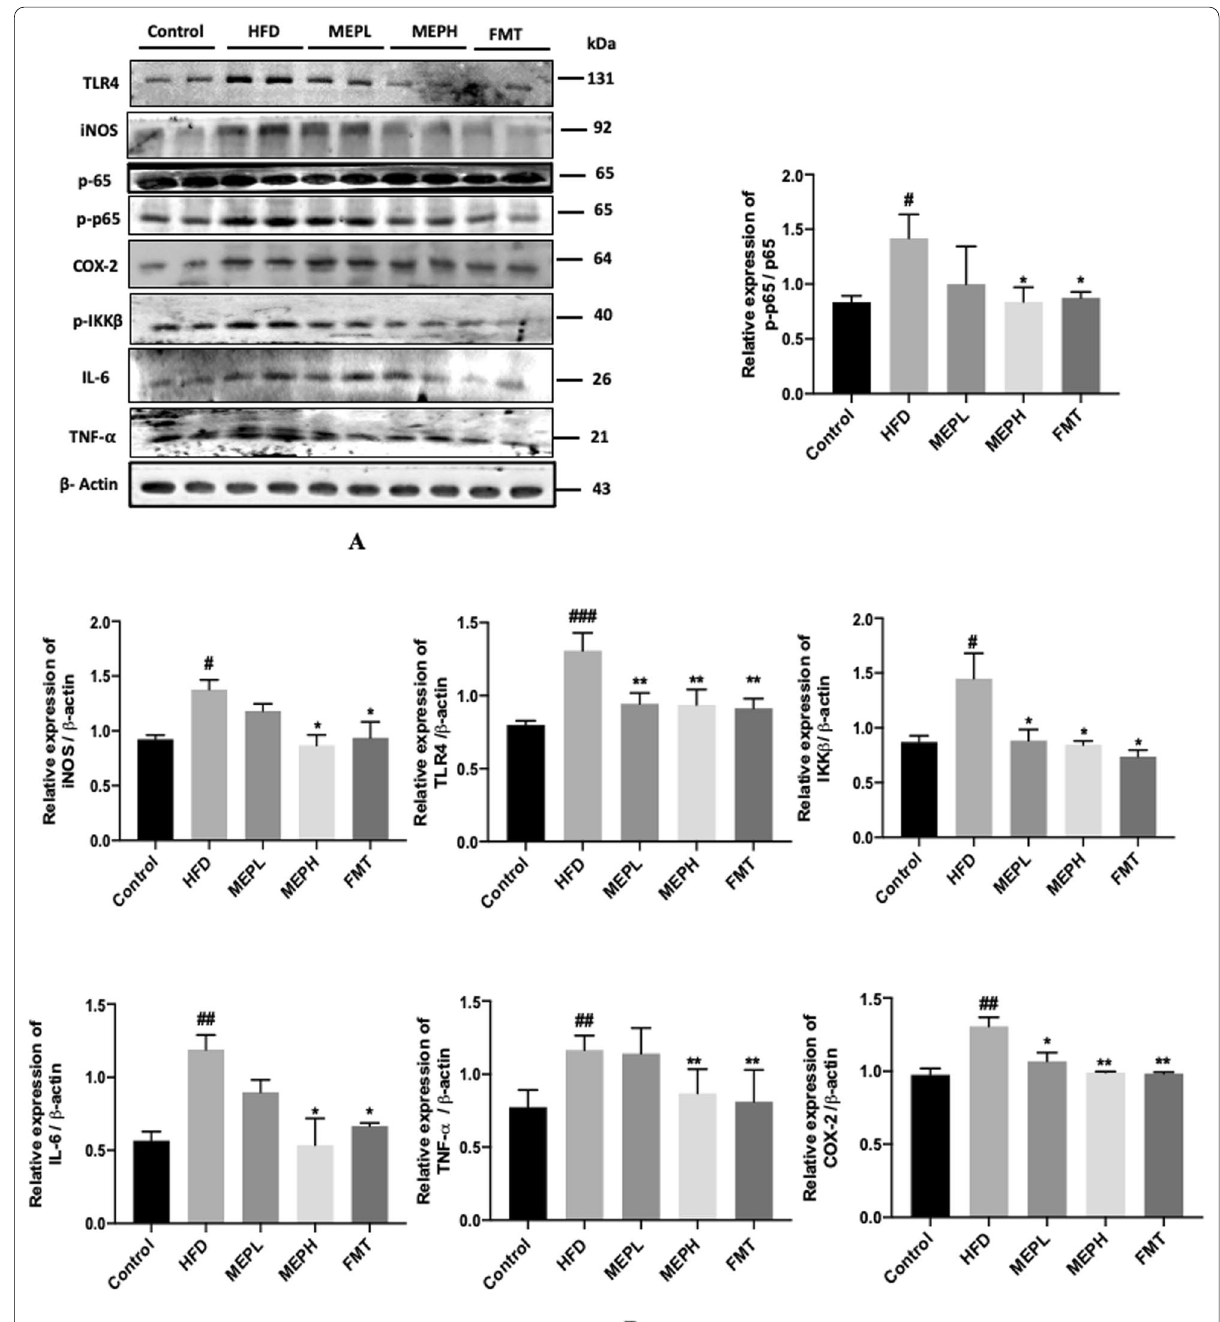
Fig. 6 Effect of MEP on the regulation of inflammatory-related signalling pathways. A Western blot analysis of TLR4, iNOS, COX-2, p-IKKβ, p-p65, TNF-α, and IL-6 protein expression levels in the colon. B Bar graph showing quantification of the western blot of the respective protein against β-actin as an internal control by image J software. The data was obtained by three independent experiments and is expressed as mean (n 4). Significant differences were presented using # p < 0.05, ## p < 0.01, ### p < 0.001 and #### p < 0.0001 vs. Control group and *p < 0.05, **p < 0.01, = ***p < 0.001 and ****p < 0.0001 vs. HFD